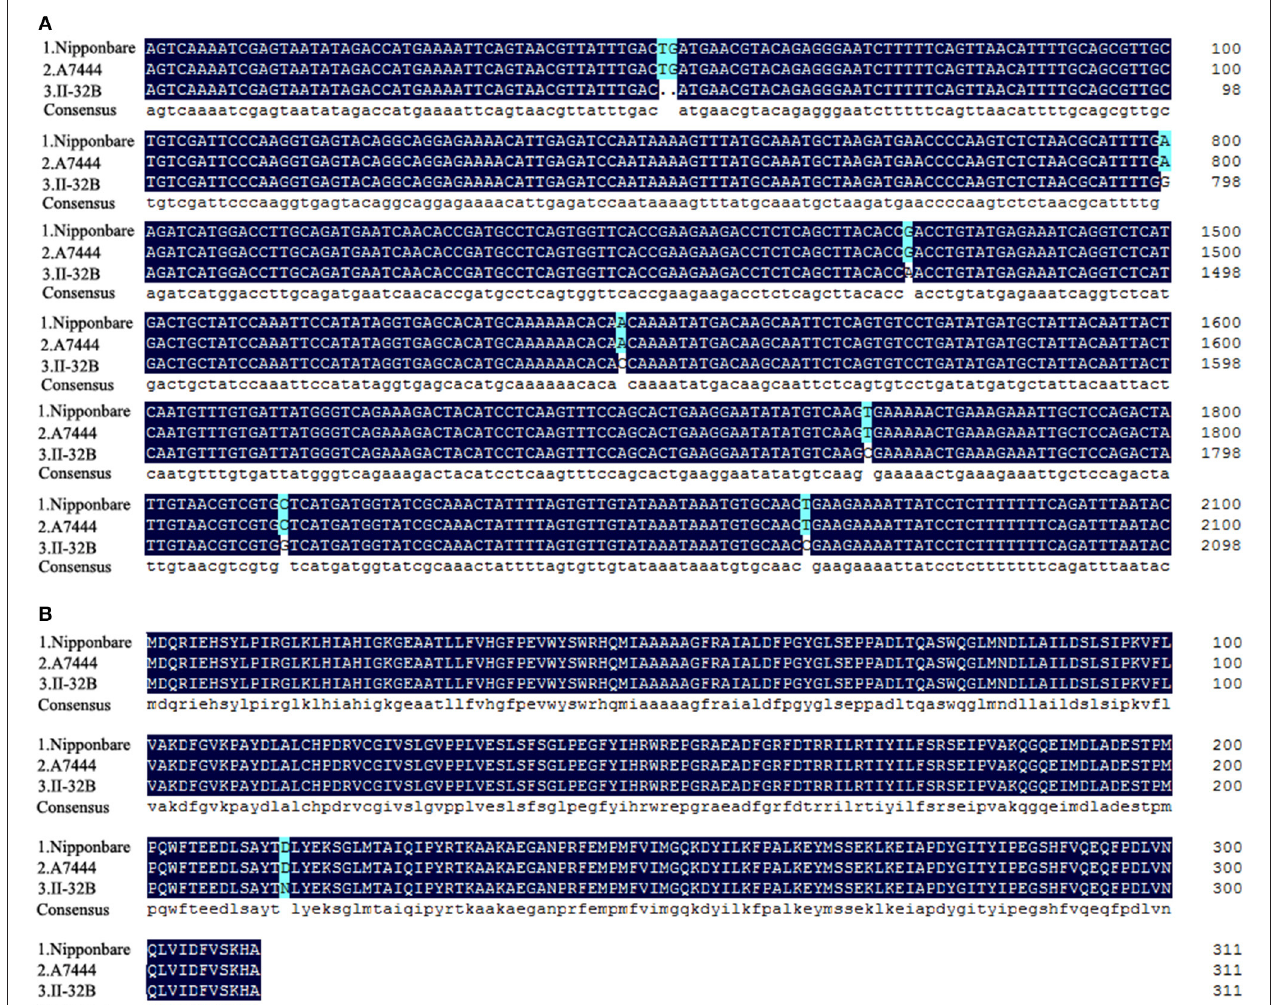
FIGURE 4 | Gene sequence and deduced peptide sequence alignment of EUI2 between two parents (A7444 and II-32B) and Nipponbare. (A) Gene sequence. We show only the alignment results of the variance sequence; the alignment results of the no-difference sequence are not shown. (B) Deduced peptide sequence.